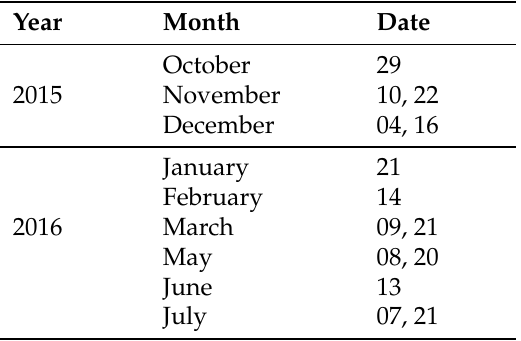
Table 1. Sentinel-1 Acquisition dates over Campo Verde.